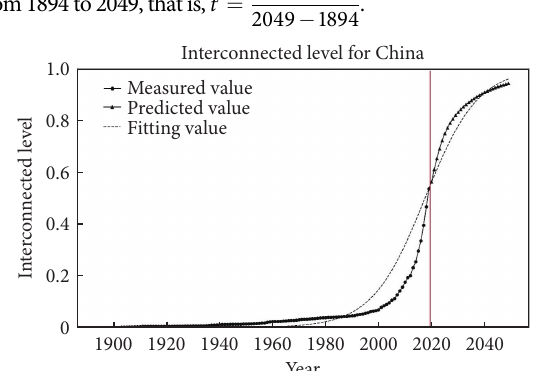
Fig. 1 Measurement and prediction of the interconnected level for China. The black solid circles and connecting lines on the left side of the red vertical line (2020) are the measured interconnected levels in history, and the black solid triangles and connecting lines on the right are the predictions of the interconnected levels based on logistic function fitting. The black dashed line is the fitting logistic function (Eq. (1)) based on the measured and predicted values of the interconnected